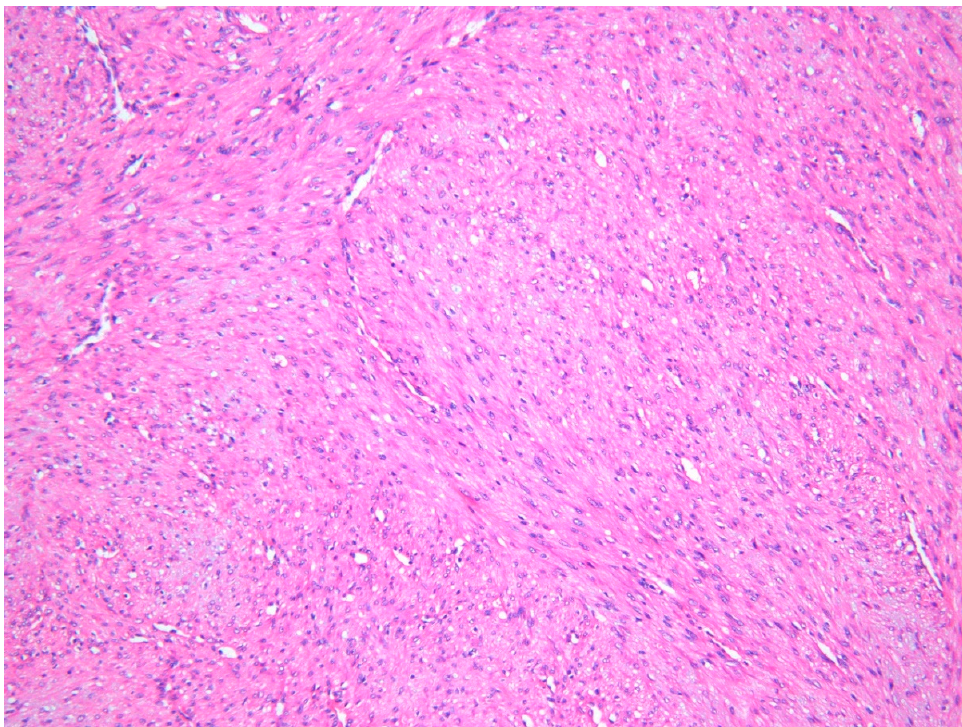
Figure 1. Photomicrograph exhibiting low-grade myofibroblastic sarcoma (LGMS) composed of spindle-shaped cells arranged into fascicles—Case 1 (hematoxylin and eosin stain ×10).